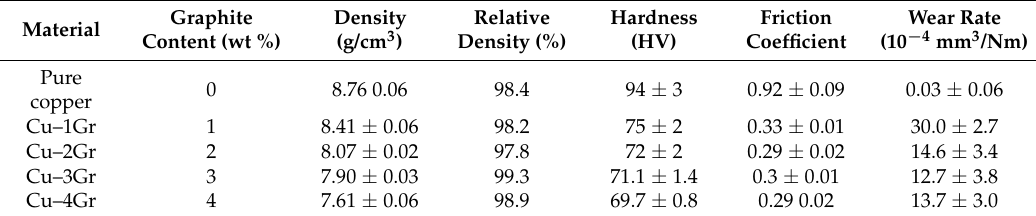
Table 2. Properties of sintered